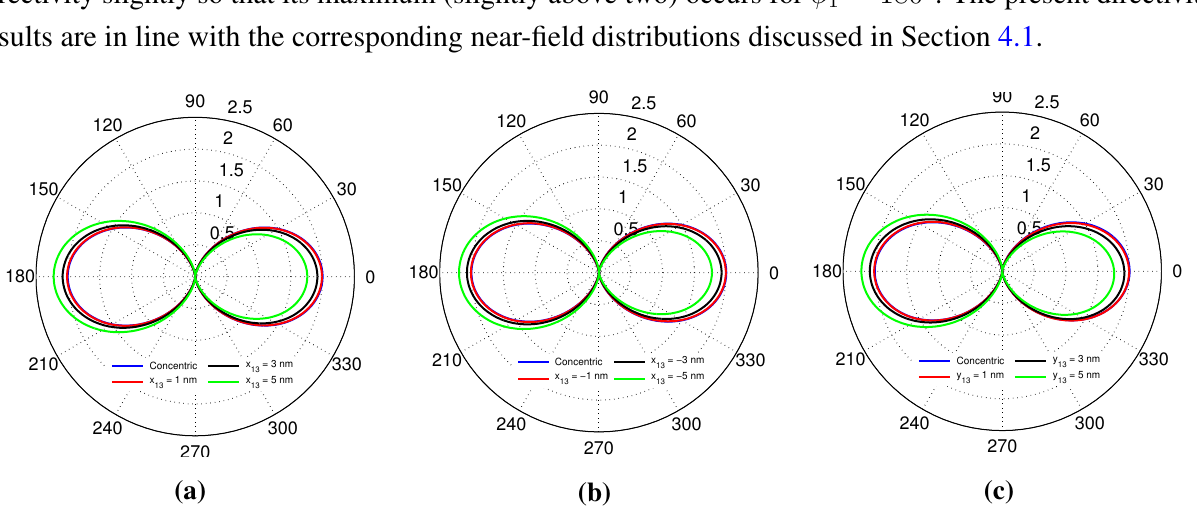
-axis, as well as along ( c ) 1